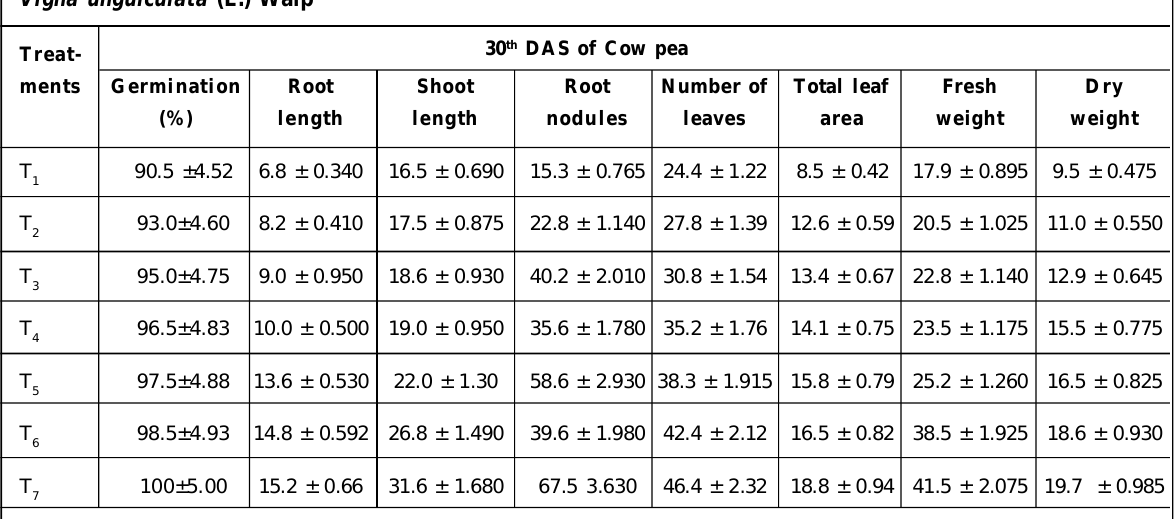
Table 1: Effects of different microbial fertilizers on growth parameters of cow pea Vigna unguiculata (L.) Walp Treat- 30 th DAS of Cow pea ments